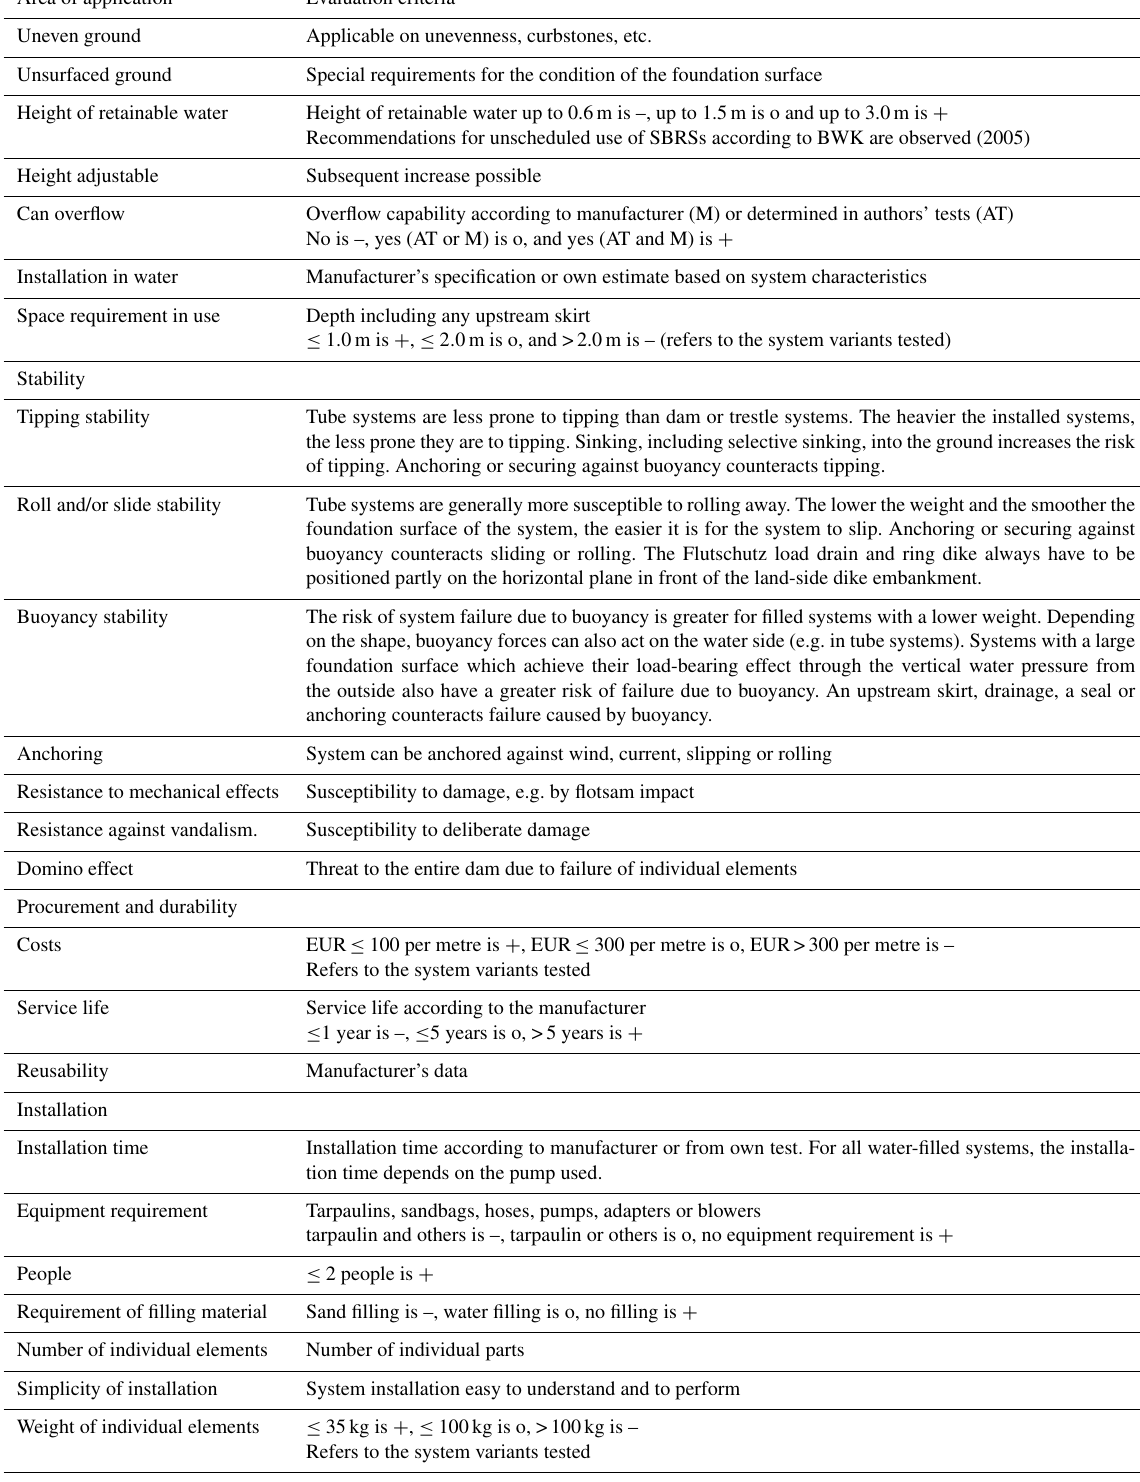
Table 4. Evaluation